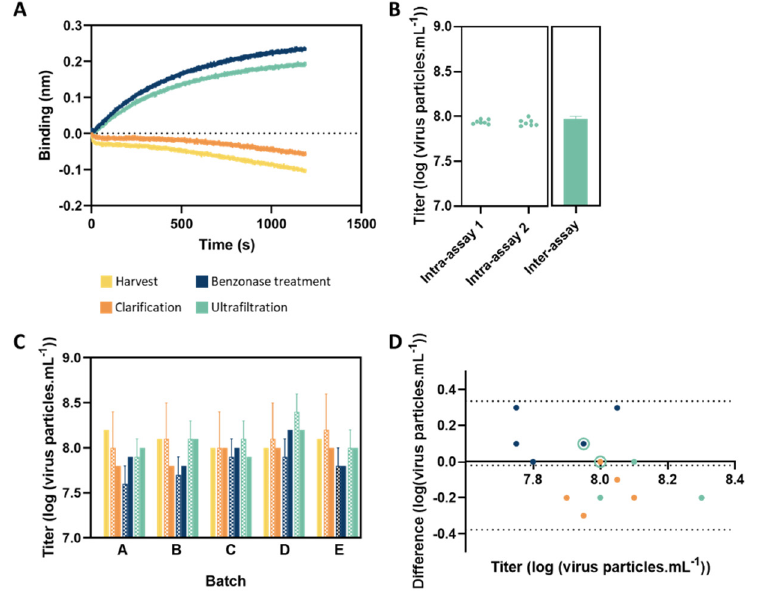
Figure 3. ( A ) Representative binding response of in-process samples from different stages of the bioprocess. ( B ) Method precision and repeatability. Inter-assay precision was evaluated by analyzing three independent sample preparations (ultrafiltered sample) in three independent analyses. Re- peatability was assessed in two independent assays analyzing seven independent samples per assay ( C ) In-process sample quantification analysis using CC ID50 (pattern bars) or BLI (full bars). Error bars correspond to the standard deviation for the CC ID50 method. ( D ) Bland − Altman plot showing the differences between the titer obtained with Octet and CC ID50 methods. The dotted lines represent the limits of agreement given by the 95% confidence intervals for the mean bias and the dashed line represents the mean bias from the Bland − Altman plot (the closest to zero, the more similar the results evaluated). Sample Clarified (batch C) (titer 8.0 log, difference 0 log) and sample Benzonase treated (batch C) (titer 7.95 log, difference − 0.1 log) overlapped with samples Ultrafiltered (batch E) and Ultrafiltered (batch A), respectively. For visual purposes, the empty circle symbol was used when sample values overlapped. In this case, two ultrafiltrated samples are represented with an open cyan-colored